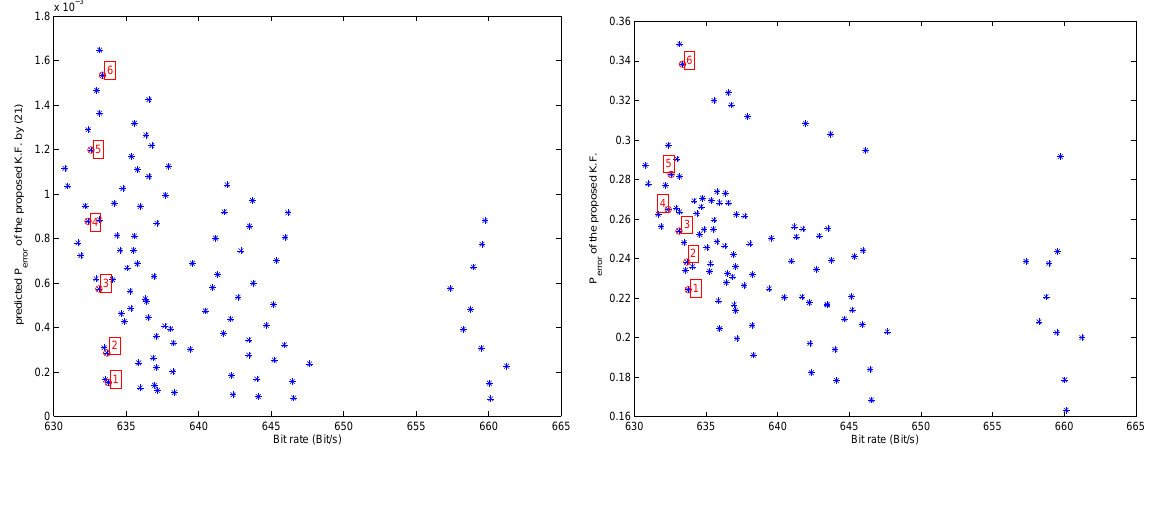
Figure 9. Bit rates and P : predicted value by (21) and the experiment result. error